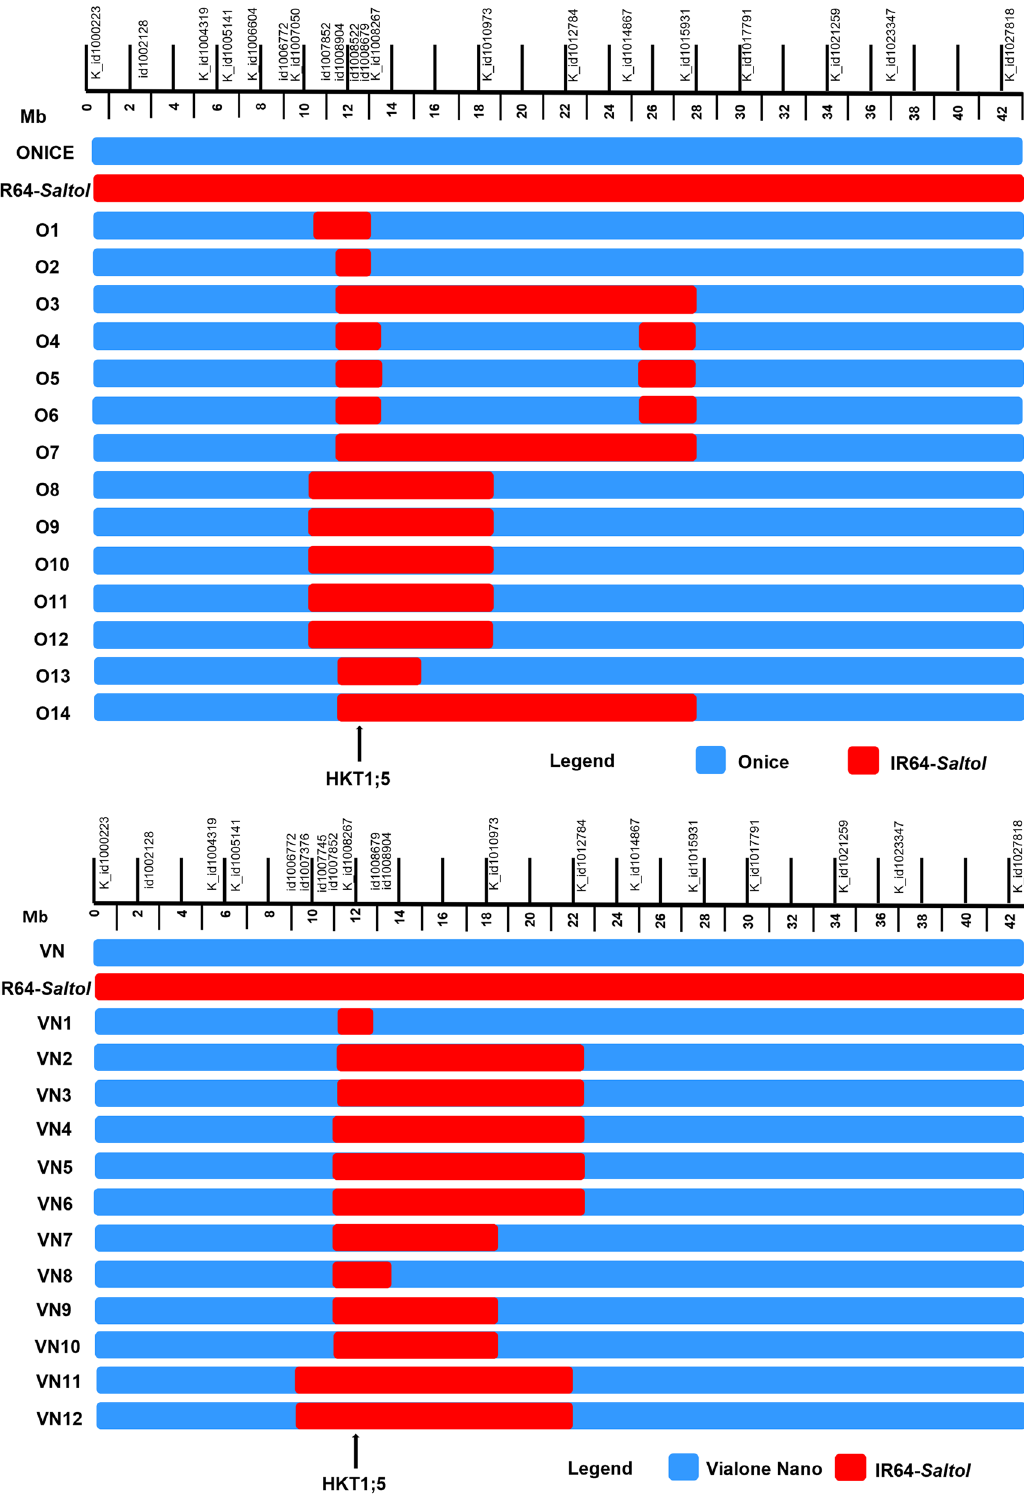
Fig. 3 Graphical representation based on the 96 KASP marker alleles of Onice and Vialone Nano “Best introgression BC 3 F 4 lines” (for Onice, from O1 to O14; for Vialone Nano, from VN1 to VN12) carrying HKT 1;5 Saltol QTL, depicting the extent of recovery of the carrier chromosome